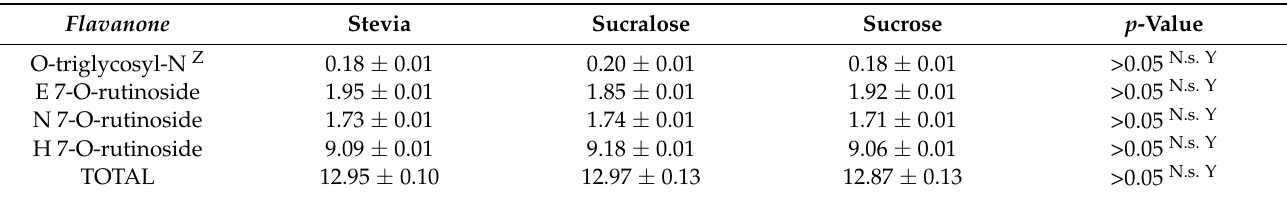
Table 1. Flavanone composition (mg/100mL) of the maqui-citrus beverages.